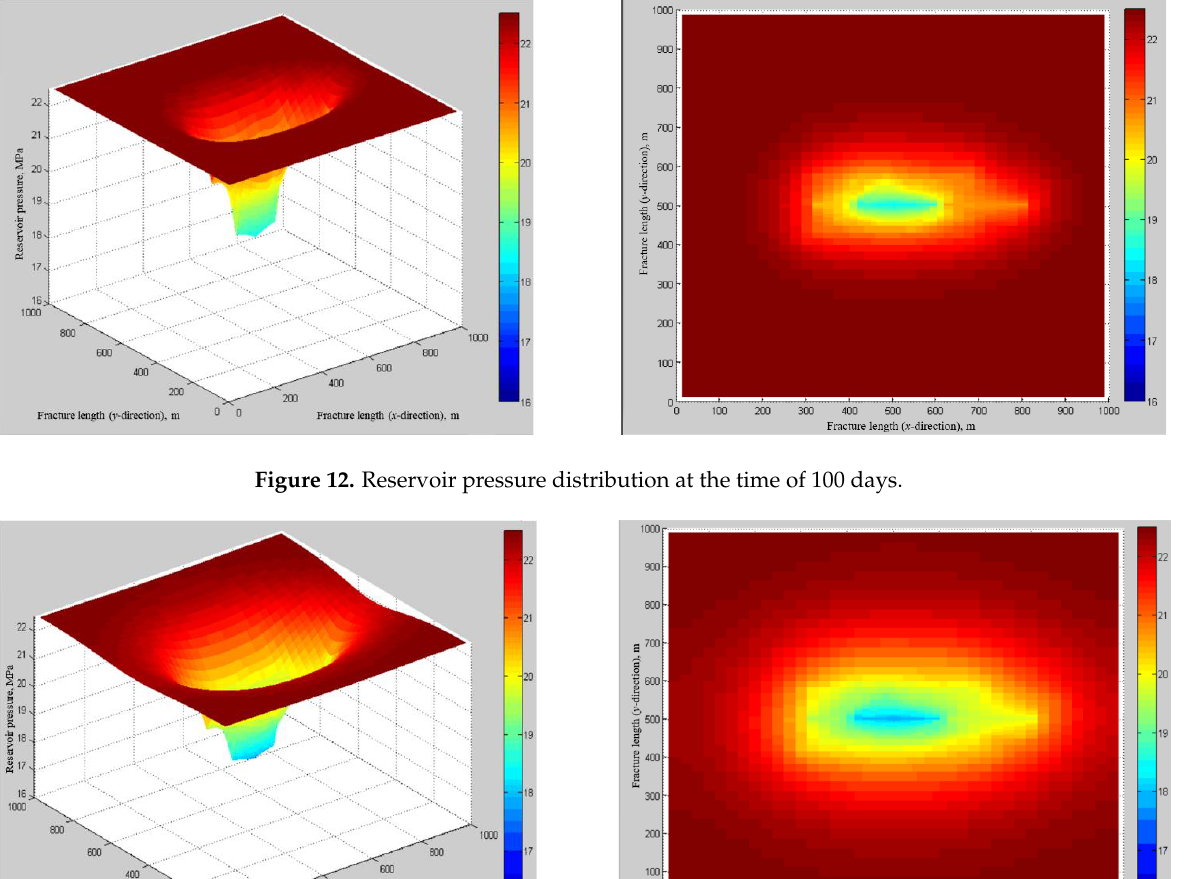
Figure 11. History matching of production rate.